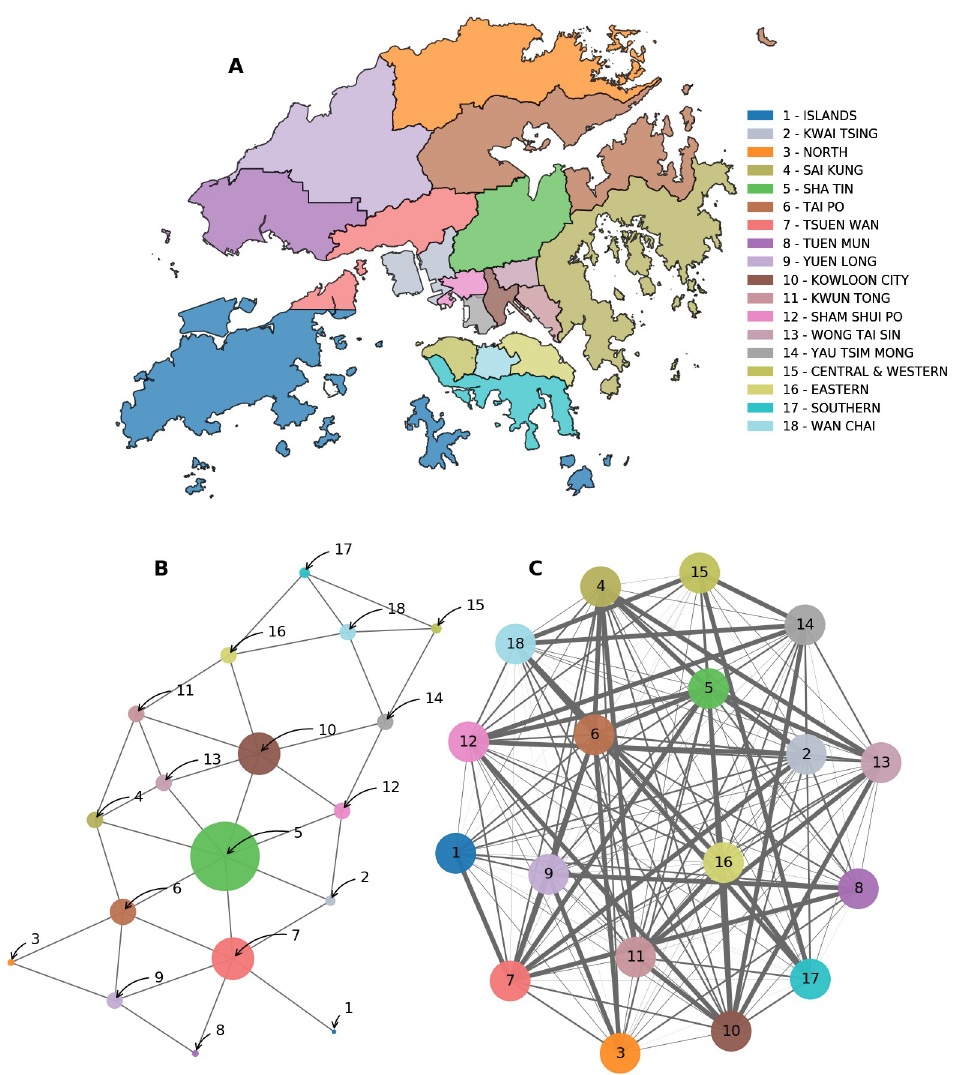
Fig 2. Spatial networks of Hong Kong’s districts. ( A ) We cross-reference the roads and bridges connecting these districts to build a spatial network [63, 64]. ( B ) We demonstrate the first undirected network layout of Hong Kong’s districts. Districts (nodes) are linked if they border each other or share a direct road/bridge in a binary fashion. ( C ) We show a fully connected version of the network. For the fully connected network, edges to neighboring districts are weighted exponentially. Different weighting schemes can be applied here, however, for our application we use the spatial distance measured by the length of the shortest path connecting any two districts on the network.